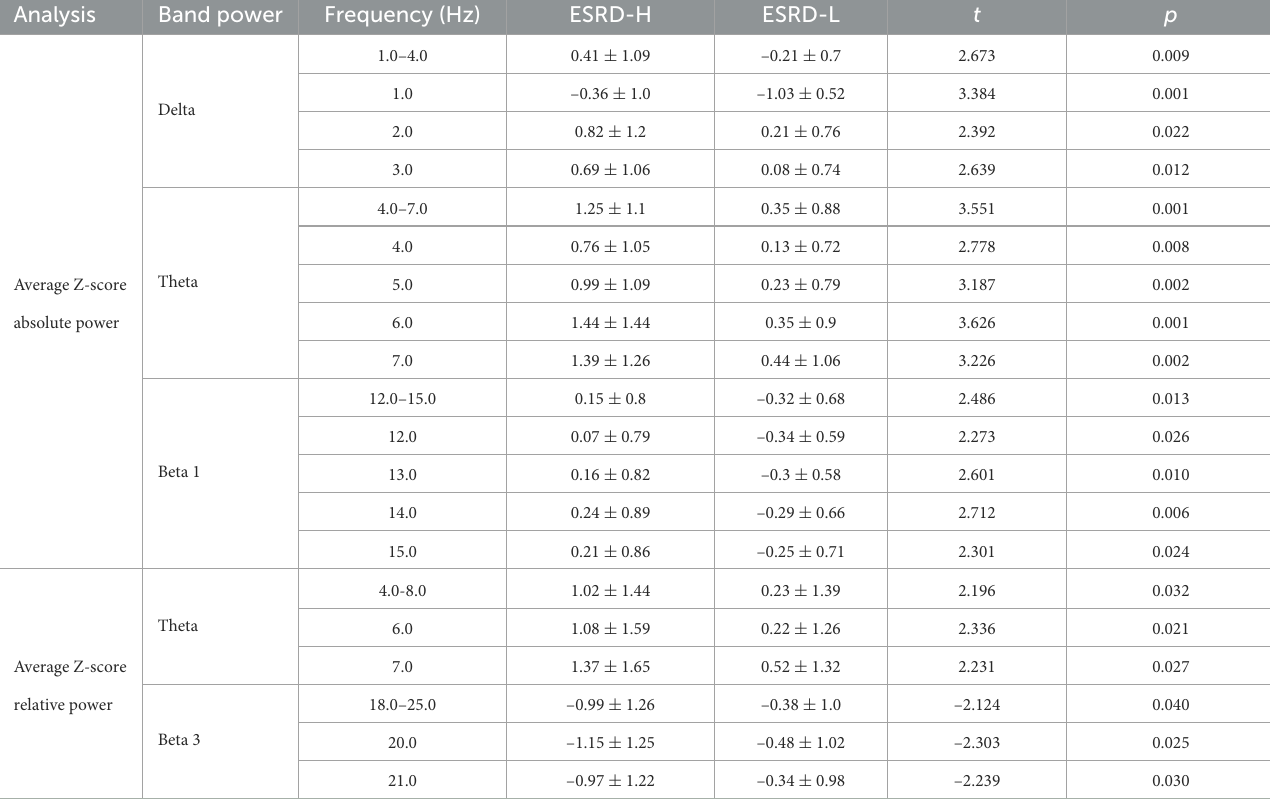
TABLE 3 The global mean comparison in the univariate QEEG analysis.